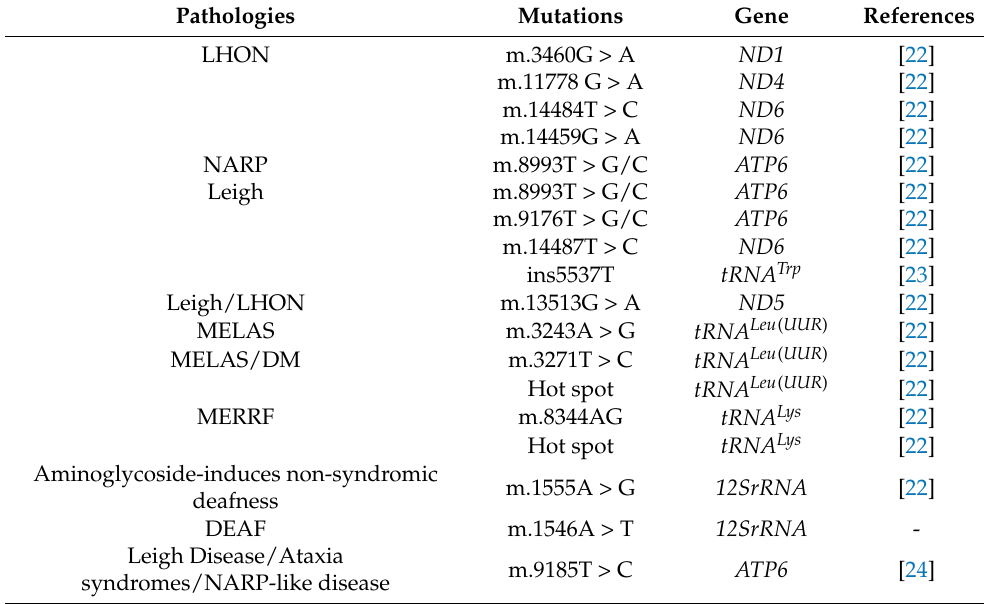
Table 1. The most frequent mitochondrial mutations and associated